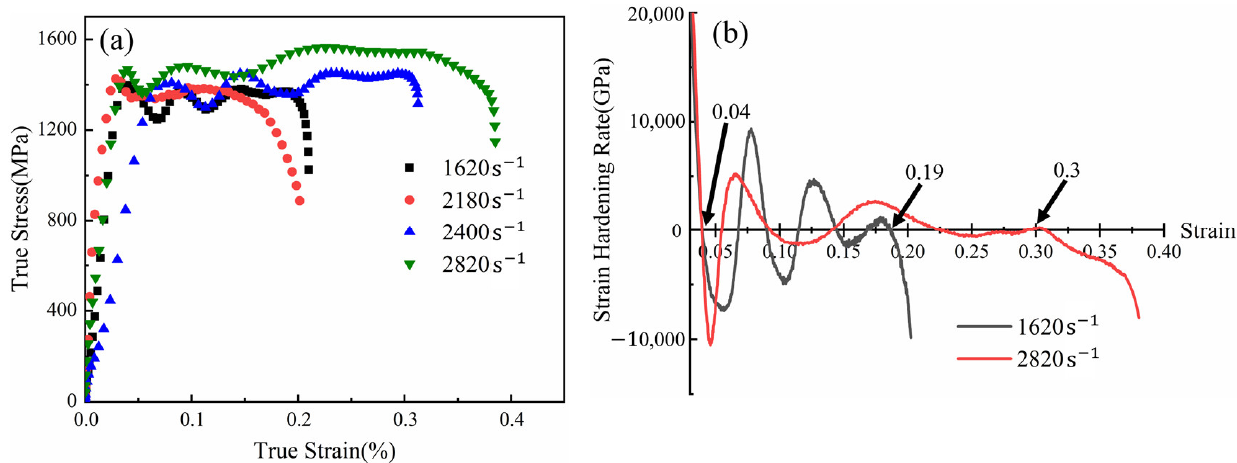
Figure 3. ( a ) Dynamic true stress−strain curves and ( b ) strain hardening rate of the Ti-6Al-1Mo-2Zr-0.55Fe-0.1B alloy. Table 3. Dynamic mechanical property data of the Ti-6Al-1Mo-2Zr-0.55Fe-0.1B and Ti80 alloys. Alloy